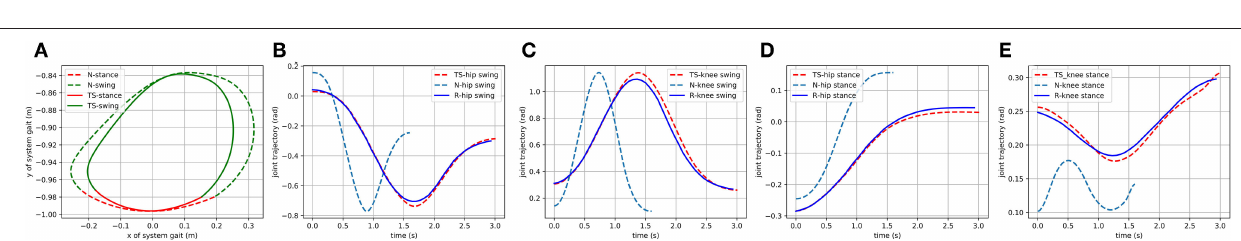
FIGURE 13 | The temporal scaled gait and joint trajectories. The gait could be composed of the trajectories during stance and swing. For example, in (A) , the dotted lines are the normal ones used as reference labeled as N-stance and N-swing, and the solid ones are the temporal scaled marked as T-stance and T-swing. (B–E) The hip and knee joint trajectories of the normal, temporal, and actual system are labeled starting with N, T, and R, respectively.